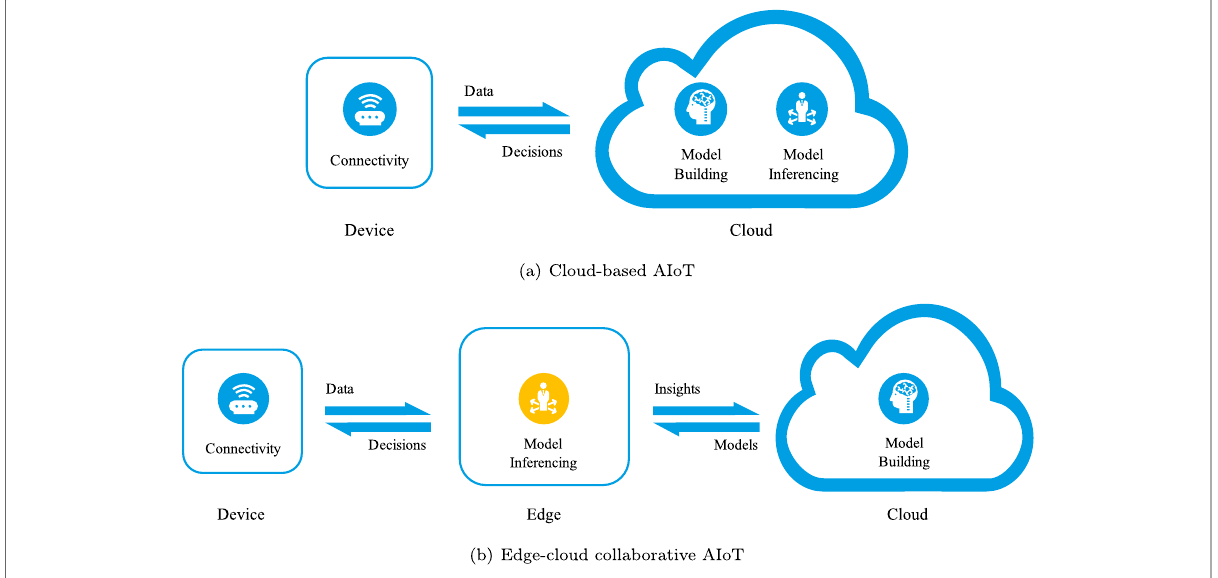
models [5], while most of the IoT devices cannot provide sufficient resources to support such computing or storage capability due to various constraints